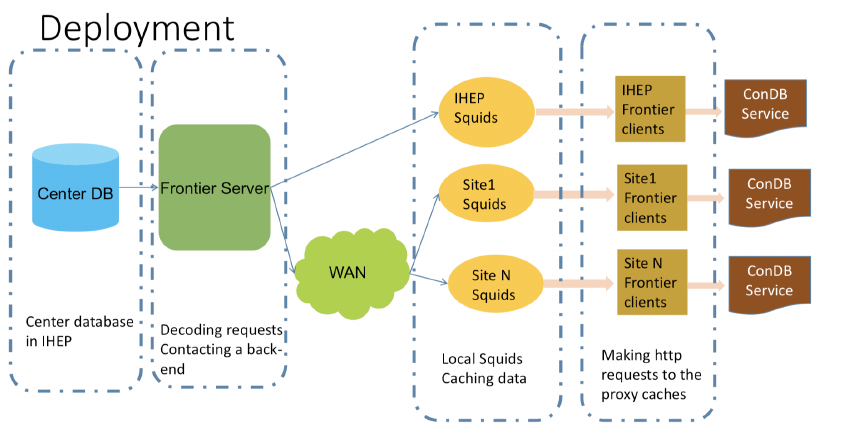
Fig. 5. The deployment of the center database, Frontier and Squid